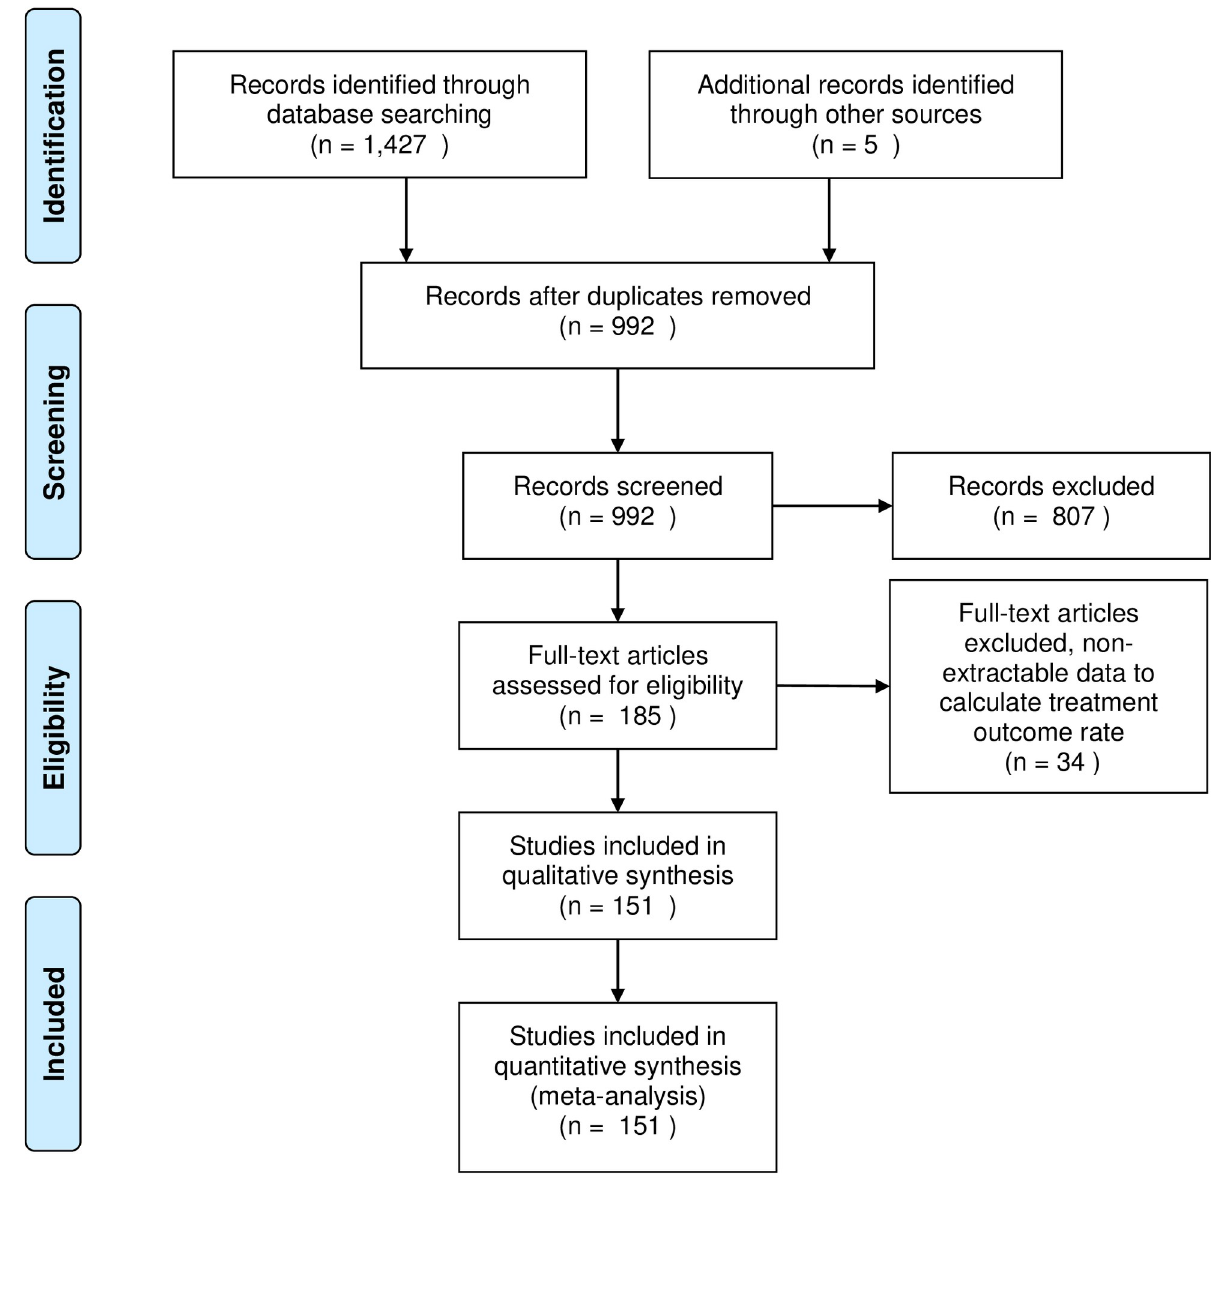
Fig 1. PRISMA flow chart indicating the result of literature search.